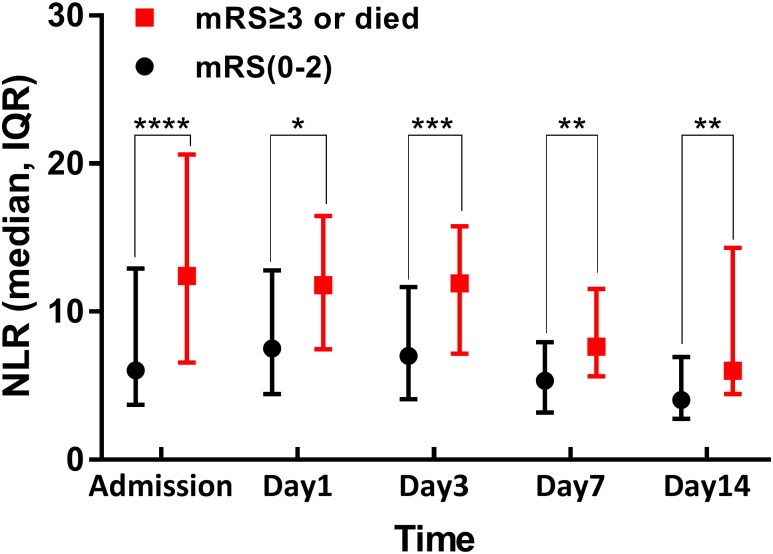
Dynamic profile of neutrophil-to-lymphocyte ratio (NLR) in spontaneous intracerebral hemorrhage (sICH) patients from admission to 14th day of hospitalization.Black bar represents functional independence group; red bar represents unfavorable prognosis group. There were significant differences between both groups at each time point (*p < 0.05; **p <0.01; ***p < 0.001; ****p < 0.0001).